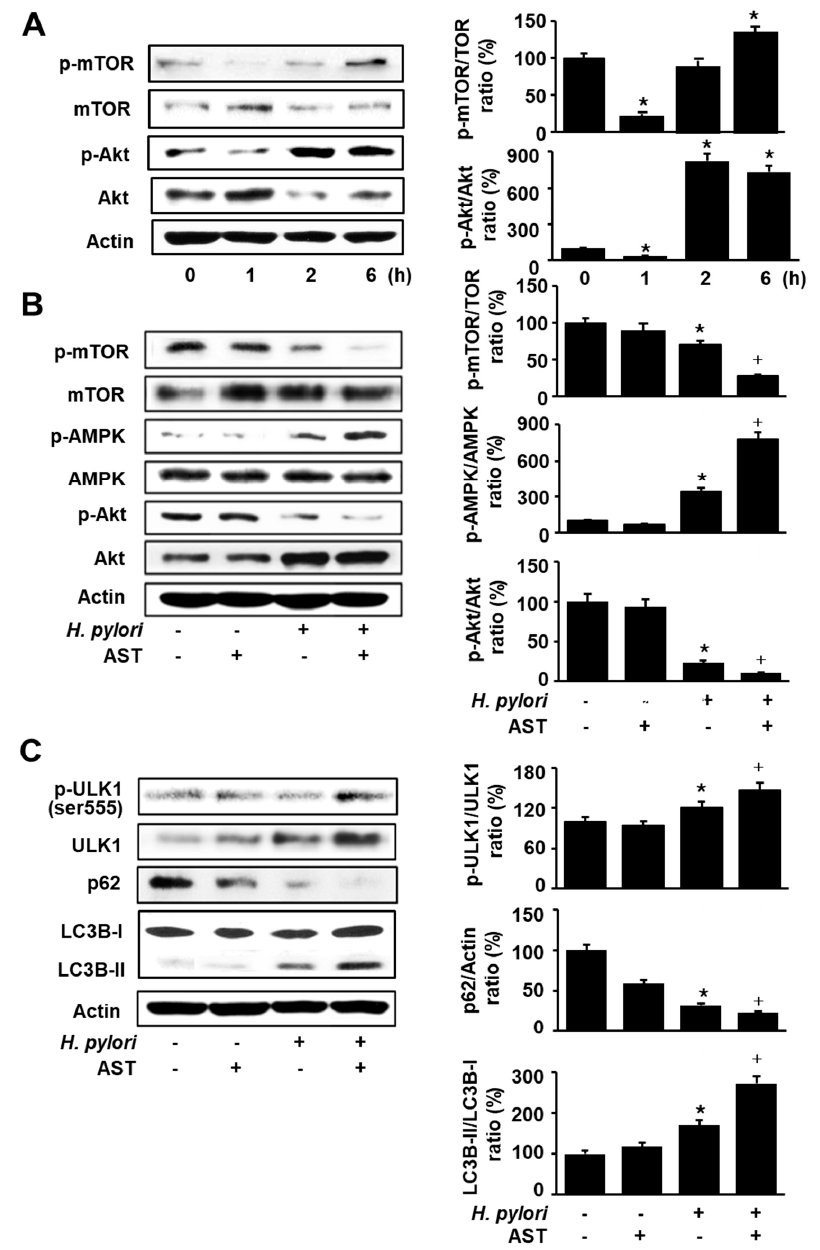
Figure 3. E ff ect of astaxanthin on phosphorylation of mammalian target of rapamycin (mTOR), Akt, and AMP-activated protein kinase (AMPK), expression of LC3-I / LC3-II and p62, and phosphorylation of Unc-51-like autophagy-activating kinase (ULK) 1 in H. pylori -stimulated AGS cells. ( A ) The cells were stimulated with H. pylori (cell to H. pylori ratio of 1:50) for the indicated time periods. * p < 0.05 vs. 0 h ( B , C ) The cells were pre-treated with 50 nM astaxanthin for 3 h and then stimulated with H. pylori (cell to H. pylori ratio of 1:50) for 1 h. The figure shows a representative Western blot for mTOR, p-mTOR, AMPK, p-AMPK, Akt, p-Akt, ULK1, p-ULK1, p62, LC3B-I, and LC3B-II protein levels and the densitometric analysis for the ratio of p-mTOR / TOR, p-AMPK / AMPK, p-Akt / Akt, p-ULK1 / ULK1, p62 / Actin, and LC3B-II / LC3B-1. Actin was used as a loading control. The data are expressed as arbitrary units obtained analyzing the bands by using the software Image J. Data are the mean ± S.E. of n = three independent experiments carried out on four samples for each experimental group. The ratio of control group was set at 100%. Control group represents the cells without H. pylori stimulation and without AST treatment. * p < 0.05 vs. control; + p < 0.05 vs. cells with H. pylori stimulation and without AST treatment. Astaxanthin